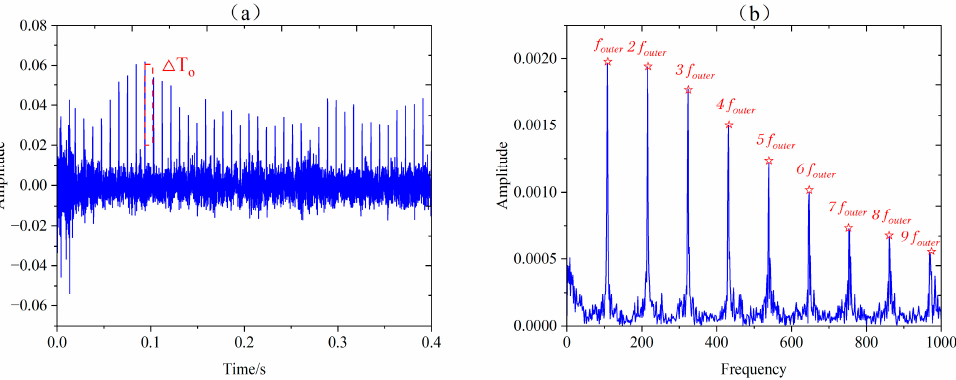
Figure 16. The outcomes produced by MDMVO-MCKD adaptively enhancing fault pulse: ( a ) The best deconvoluted signal and ( b ) its envelope spectrum.